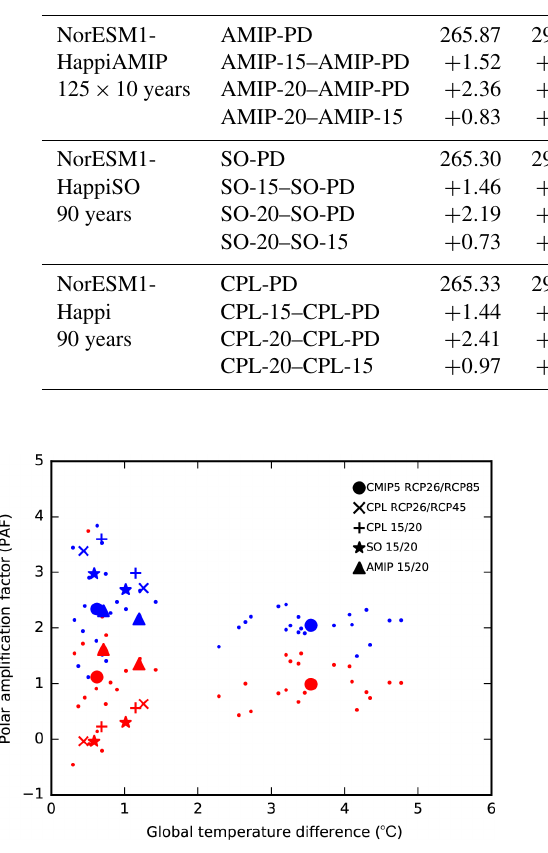
Figure 8. PAF versus the change in the global-mean near-surface temperature. Blue markers show values for NH and red markers for the SH. The small dots show the values for the CMIP5 models used in HAPPI, including NorESM1-M, for RCP2.6 (values with warm- ing below 2 ◦ C) and RCP8.5 (values with warming above 2 ◦ C). The large dots show the CMIP5 multi-model means. Also shown are the values for NorESM1-Happi for RCP2.6 (left cross) and RCP4.5 (right cross), for CPL-15 (left plus sign) and CPL-20 (right plus sign), for SO-15 (left asterisk) and SO-20 (right asterisk), and for AMIP-15 (left triangle) and AMIP-20 (right triangle). For RCP2.6, RCP4.5, and RCP8.5, the PAF is computed by differencing the 10- year period (2091–2100) from the respective RCPs to 2006–2015 from RCP8.5 (as it is commonly used to extend the historical pe- riod beyond 2005). The values from the 1.5 and 2.0 ◦ C warming runs correspond to those in Table